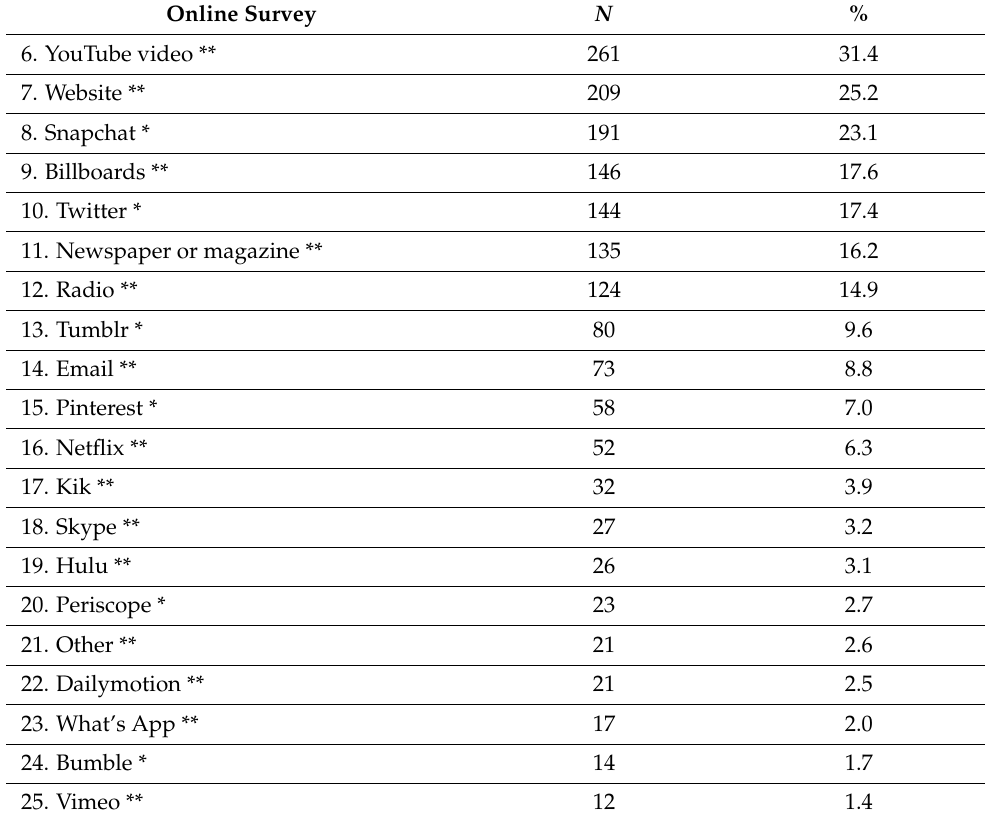
Table 3. Source of First ENDS Product, Overall and by Sex, Age, and Race/Ethnicity—Quantitative Survey. Sources Overall Chi-Square *